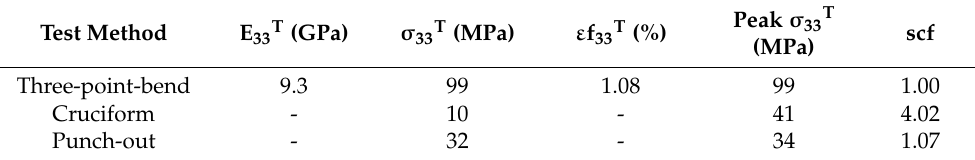
Table 7. T-T tensile properties predicted from finite element analyses for indirect geometries.